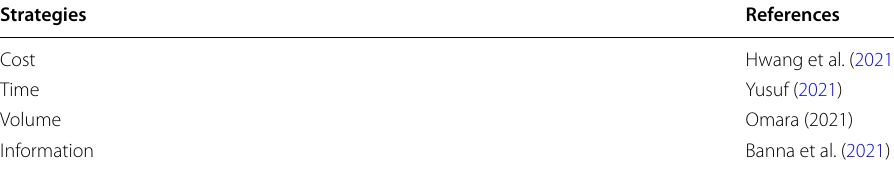
Table 10 Selected risk-based strategic priorities of fintech lending for clean energy projects Strategies